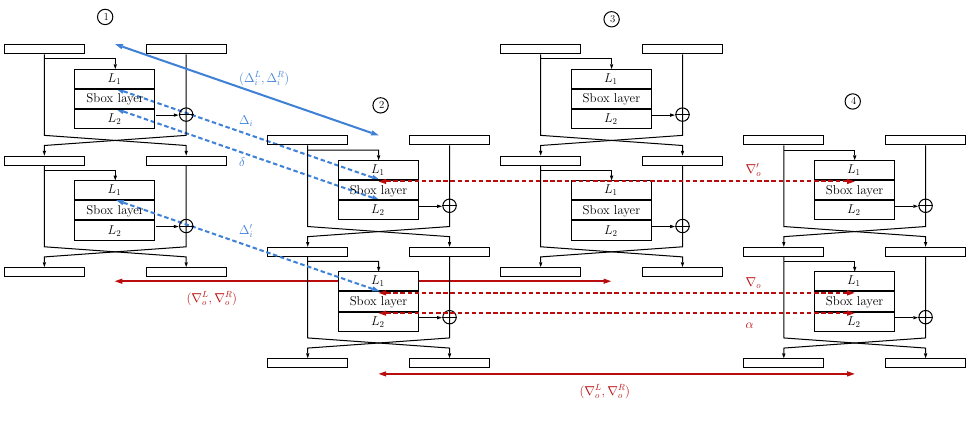
Figure 7: Boomerang Switch over two rounds of a balanced Feistel with two branches. The differences denoted with straight lines are imposed and